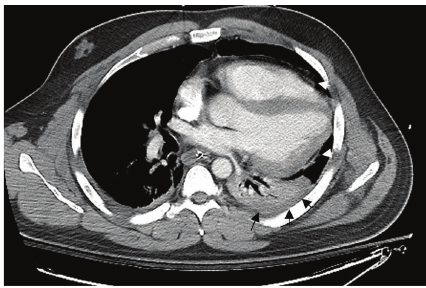
Figure 3: This CT study was performed shortly after arrival to the emergency room and shows the pericardium in an unnatural shape with the left ventricle herniating through the tear that runs vertically up the lateral aspect of the sac (white